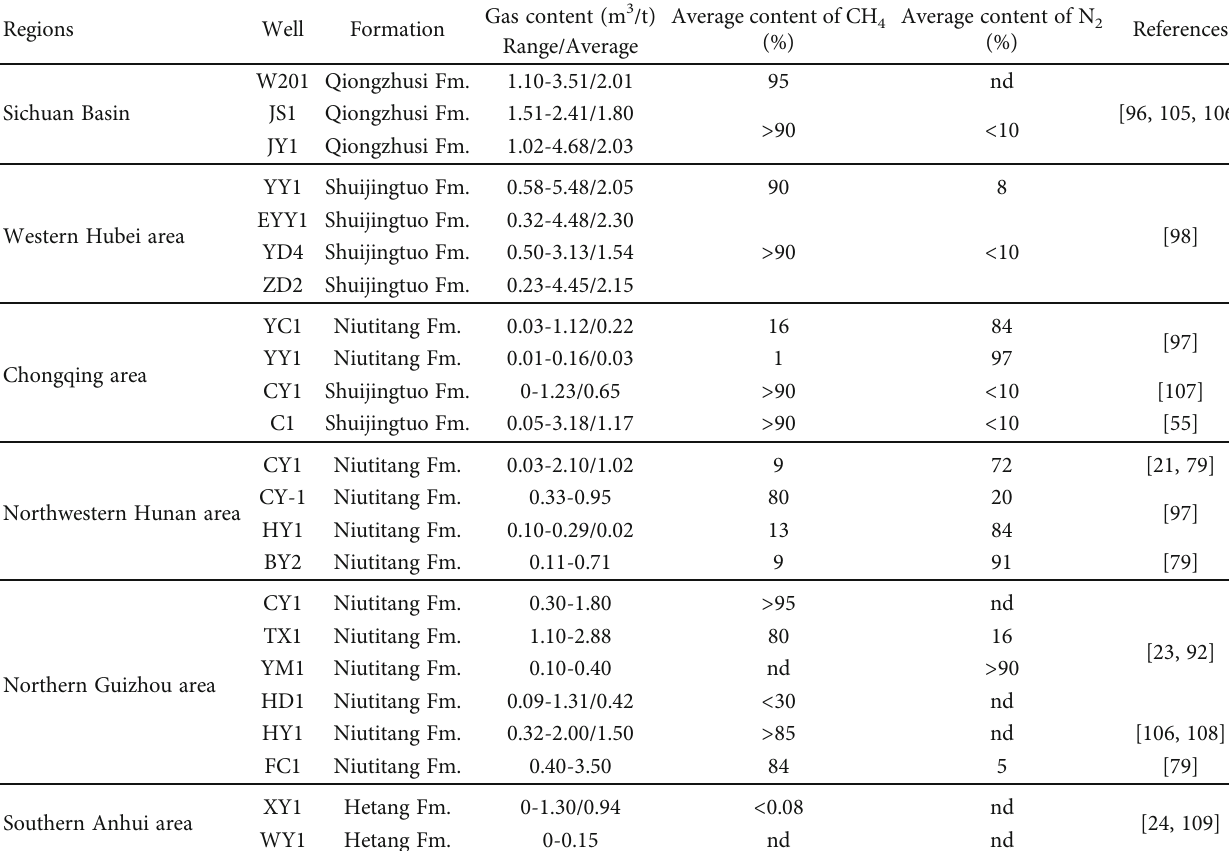
Table 2: Gas-bearing characteristics of the Lower Cambrian shales in the southern China (see Figure 2 for well locations).